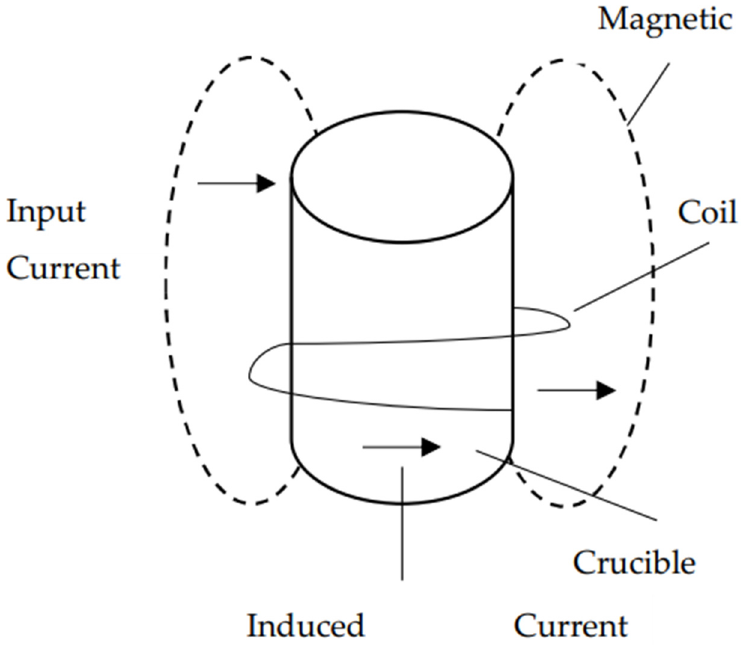
Figure 20. Simplified block diagram of induction heating [102].